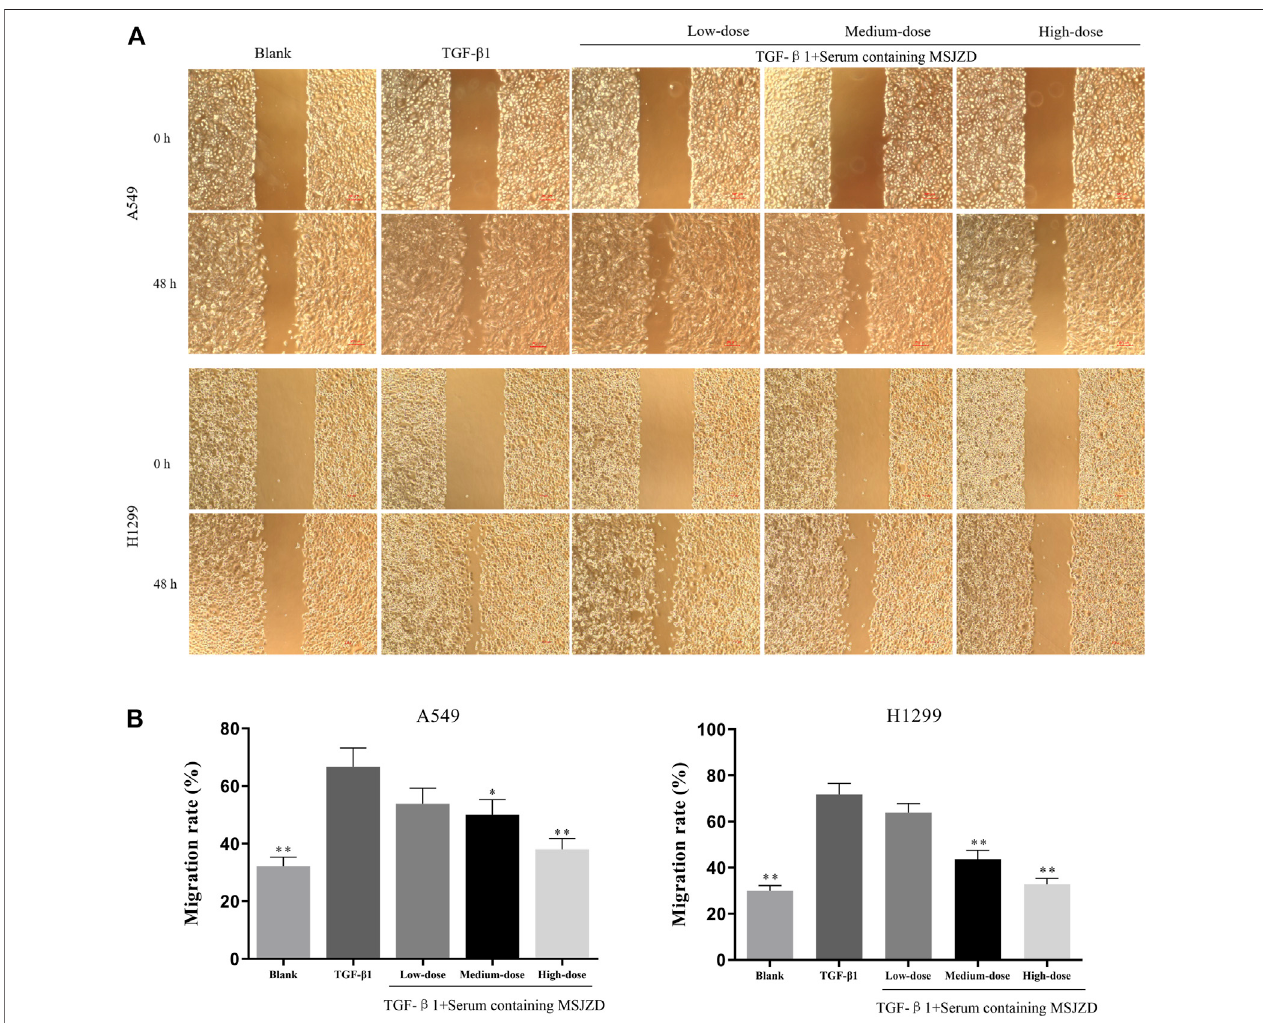
FIGURE5| Effectsofserum-containingMSJZD onthemigration ofNSCLCcells invitro .Wound healing (A) and quantitativeassay (B) wereperformedtoevaluate the migration ability of NSCLC cells. * p < 0.05, ** p < 0.01. versus the TGF- β 1 group.